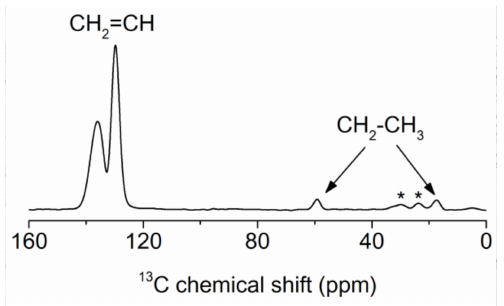
Figure 11. 1 H– 13 CPMAS spectra for sample B60-VTAS. Asterisks denote spinning sidebands.